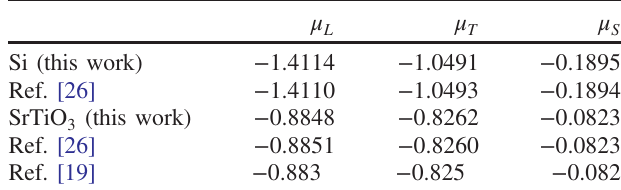
TABLE V. Flexoelectric coefficients (in nC/m) of Si and SrTiO 3 along with previous values found in the literature.